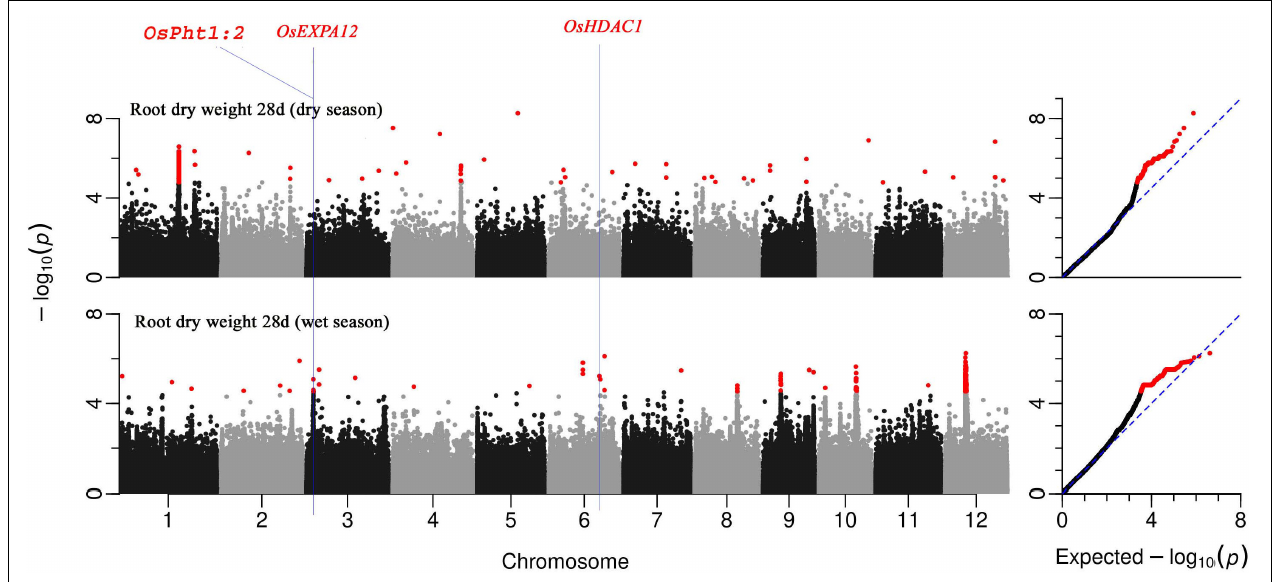
FIGURE 6 | Manhattan plots from GWA mapping of root dry weight at 28 days under DSR condition of BAAP population in wet and dry seasons. Benjamini–Hochberg adjusted probabilities > 0.1 are highlighted in the red dot. The diagonal blue line shown on QQ Plots represents a 1:1 agreement between expected